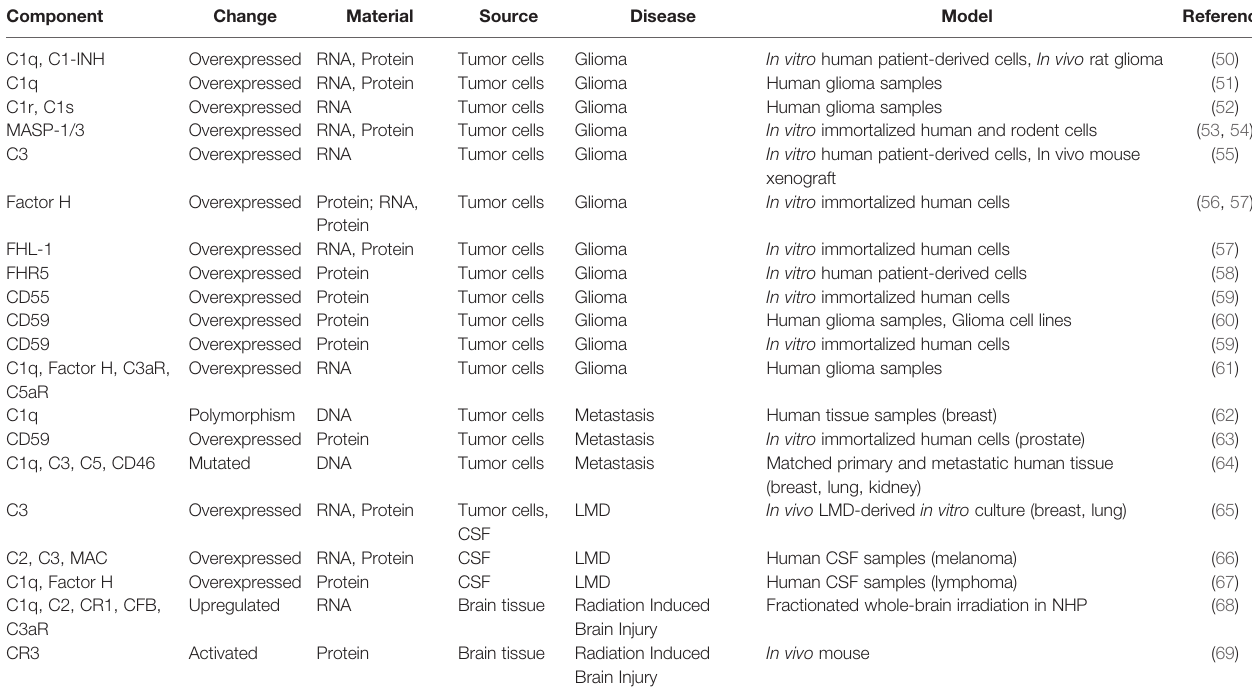
TABLE 1 | Complement expression in brain neoplasms.